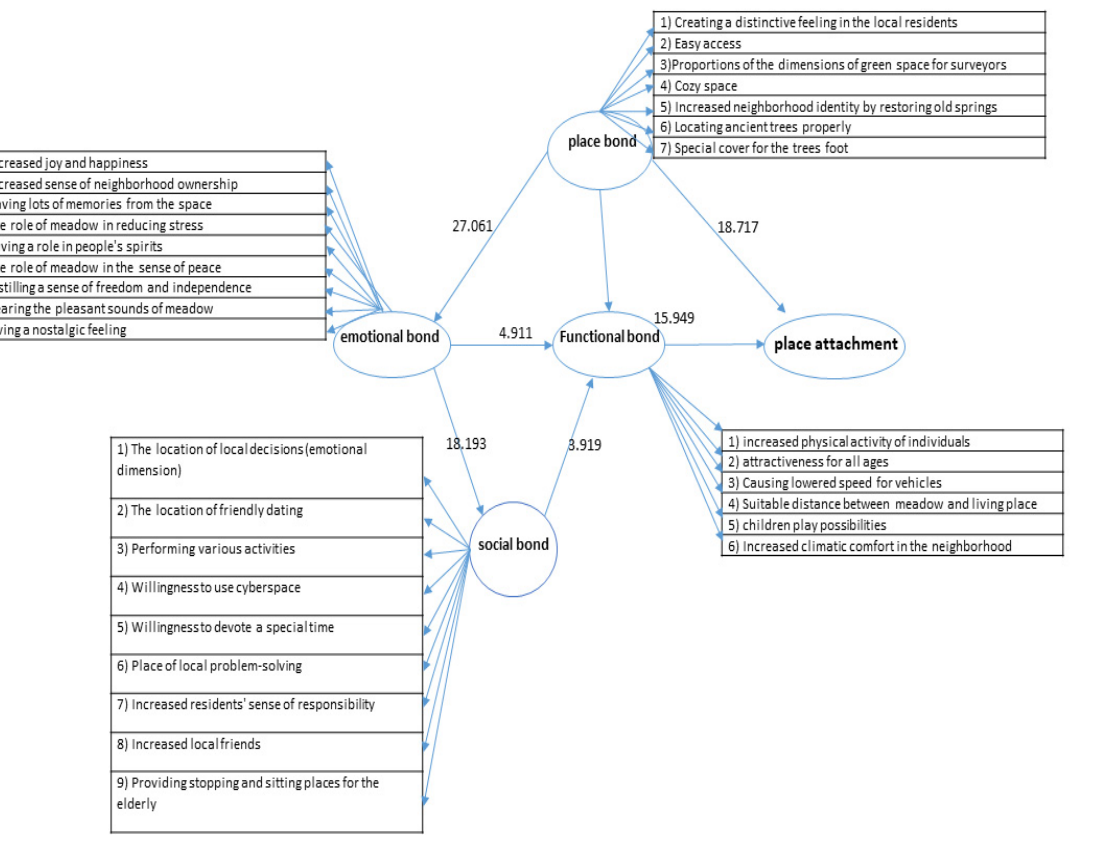
Figure 3. Model structure path coefficients. As can be seen in Table 1, the path coefficient value of 0.706 for the relationship between the place bond and the emotional bond reveals a stronger relationship with the two variables of place identity and place attachment. Also, the path coefficient of 0.637 for the relationship between the emotional bond and social bond indicates a stronger re- lationship compared to the relationship between emotional bond and place identity. 3.2. The Status of Each Research Sub-Index Using a Single-Sample T-Test This study has used a single-sample T-test to investigate each of the variables and items of research. If the T-value is greater than 0.05, the variable under study has no sig- nificant difference with the test value (i.e., number 3) and the component is at a moderate